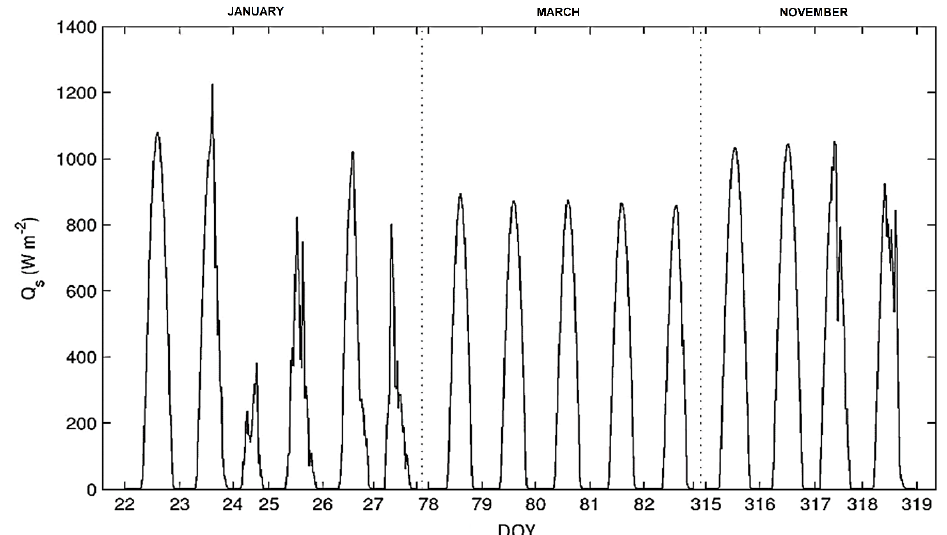
Figure 3. Solar radiation ( 𝑄 𝑠 ) during the measurement time period.